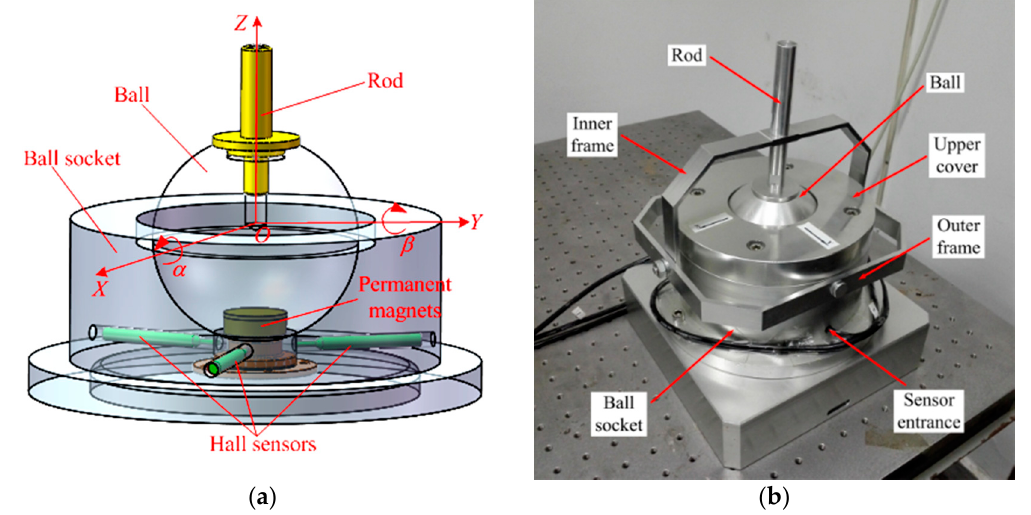
Figure 1. Prototype of the intelligent spherical joint; ( a ) structure diagram; ( b ) prototype.